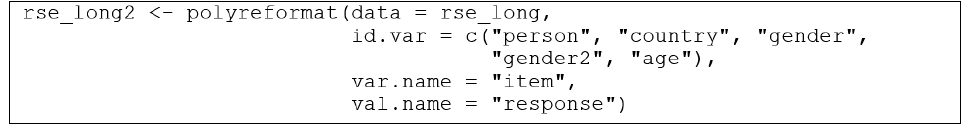
Figure 11. Convert polytomous responses to pseudo-dichotomous responses.